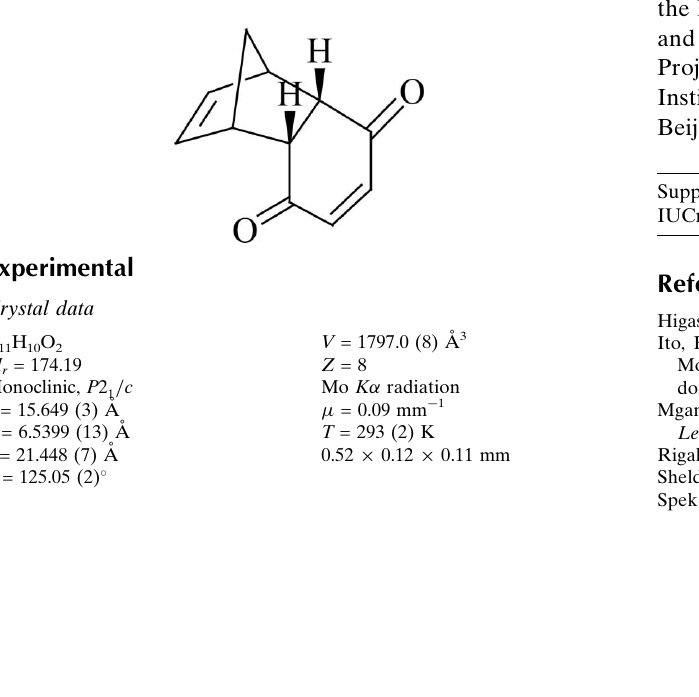
link the molecules into columns along the b axis.